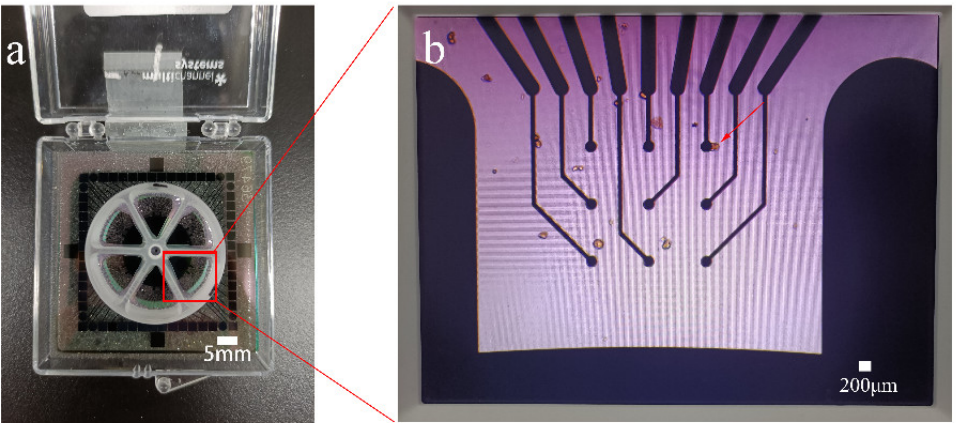
Figure 3. ( a ) An image of the MEA chip. ( b ) A chip surface after culturing the taste bud organoids for 24 h.